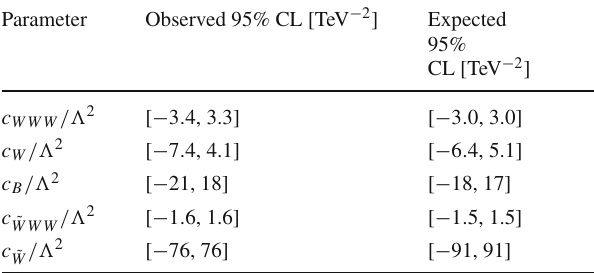
Table 6 The expected and observed 95% CL intervals for the anoma- lous coupling parameters of the EFT model [109]. There is a change in convention relative to Ref. [6] that changes the sign on some of these